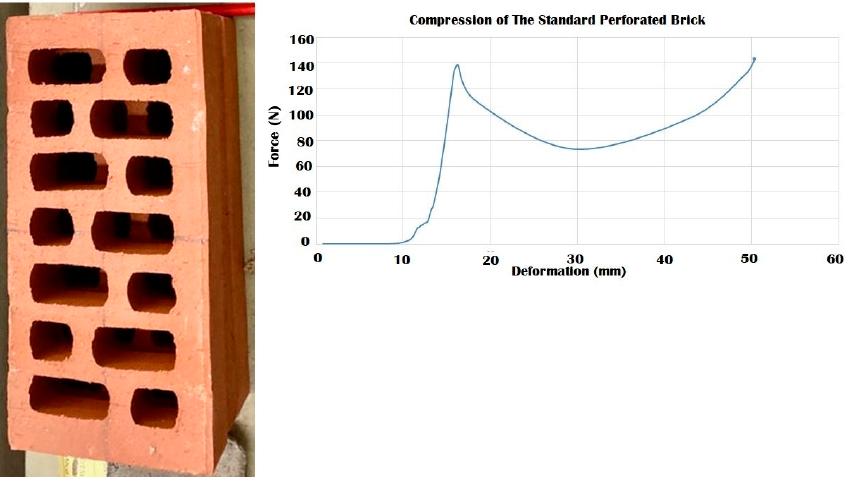
Figure 18. Exhibits the results of the compression test for the standard industrial hollow/perforated clay brick. The results show that the maximum compressive force endured by the brick was 140 N, which led the brick to its first cracking point at 15.5 mm deformation. While the brick-maintained resistance from 15.5 to 50 mm deformation under forces ranging from 70–140 N with strain value of 1.11, where it finally collapsed at 50 mm under ~140 N, which is less than the compressive strength achieved by the V1 linear and bulk brick models. It also recorded less strength than V2 bulk model brick and V3 linear model brick.